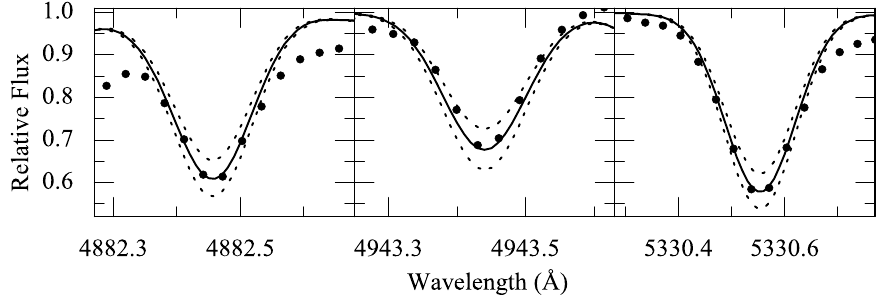
Fig. 18. Ce II lines in the spectrum of HD 209621. The synthetic profiles are given for the three cerium abundances log ϵ (Ce) = 1 . 22 ± 0 . 15.